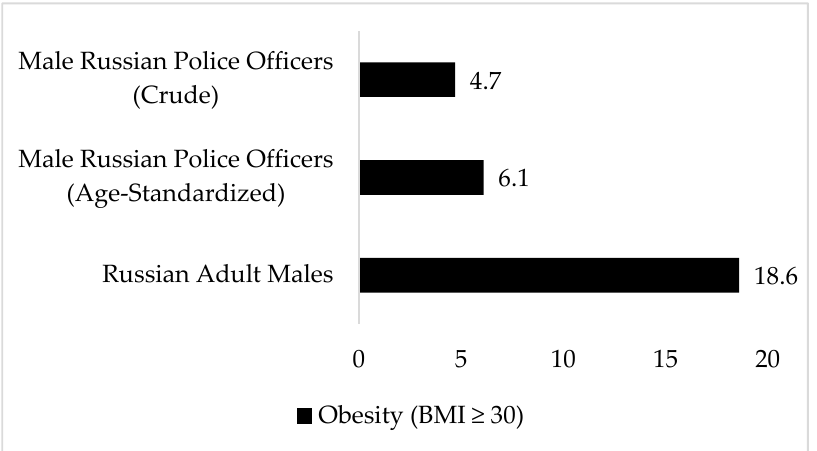
Figure 1. Age-standardized prevalence of obesity (BMI ≥ 30 kg/m 2 ) in male Russian police officers compared with Russian adults. Russian police officer rates were age-standardized using 2014 age-stratified population estimates for Russian males provided in the Central Intelligence Agency World Factbook for Russia [21]; Russian male obesity estimates are from the World Health Organization [22].